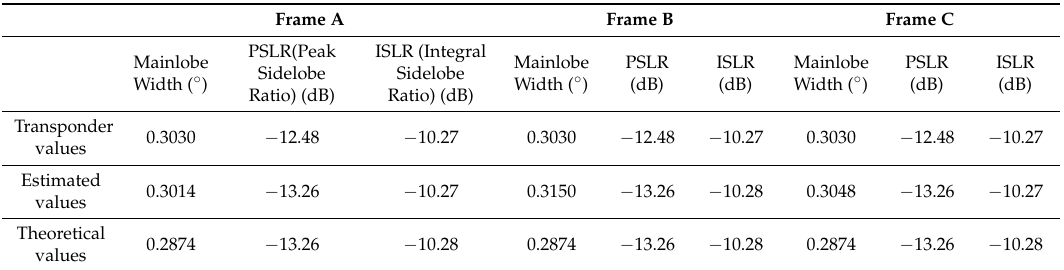
Table 6. The AAP characteristics measured with Ottawa transponder, the estimated values and the theoretical